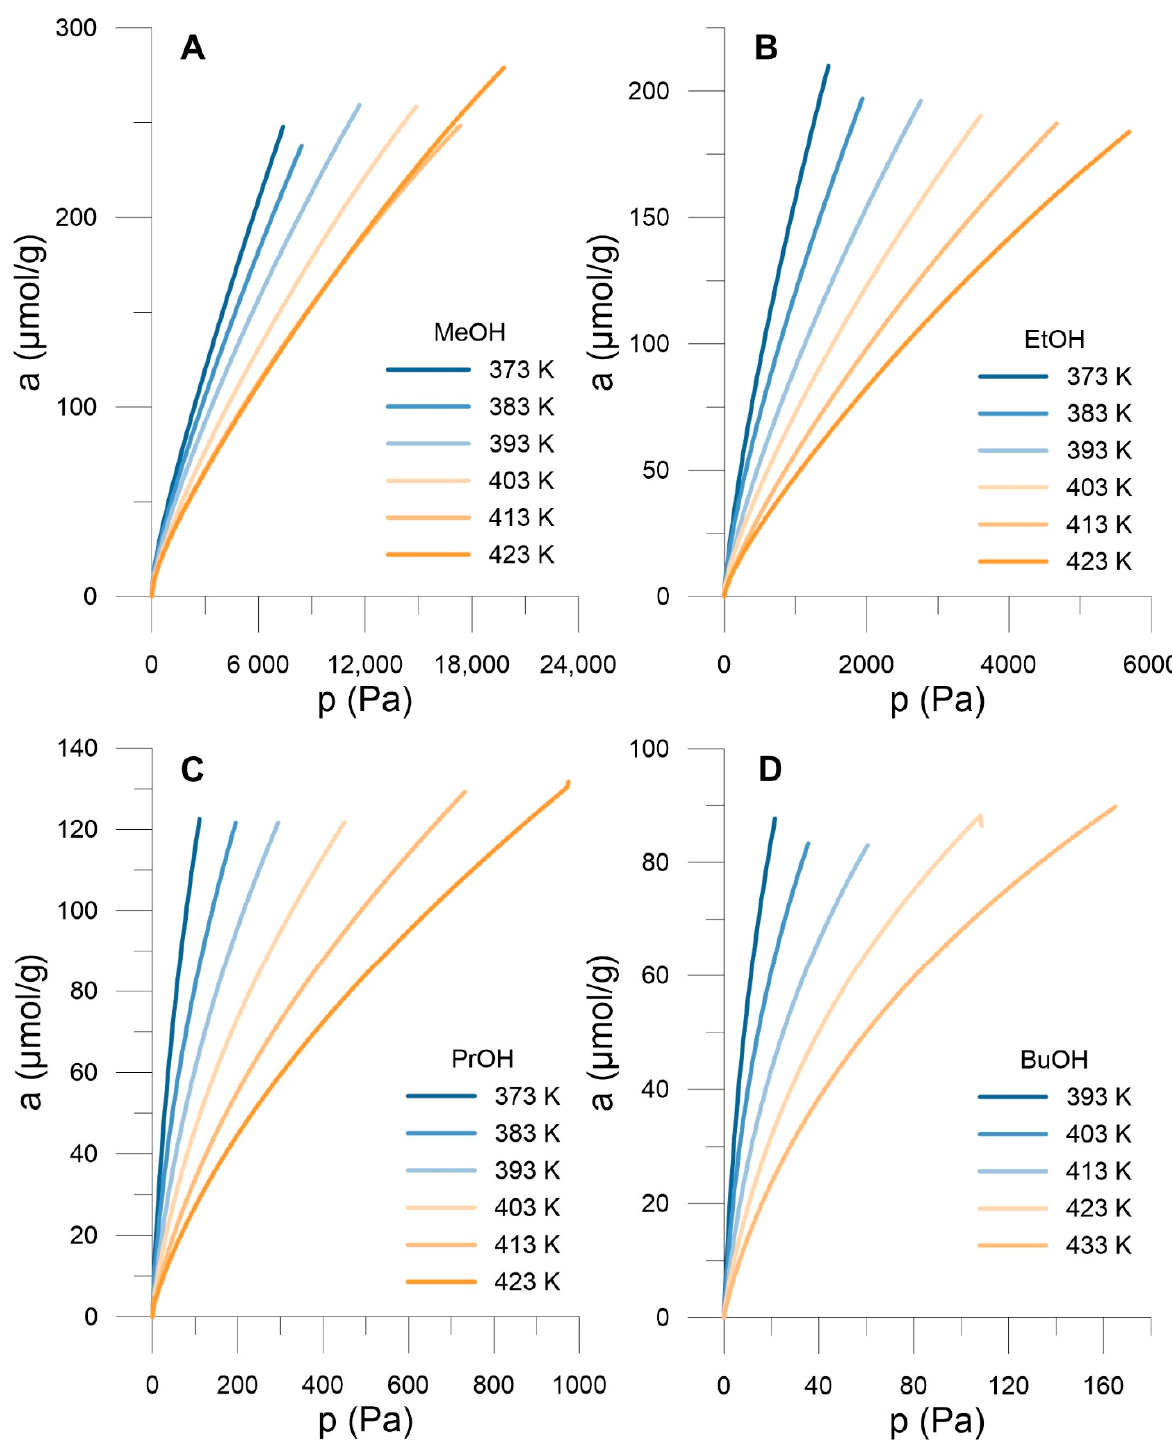
Figure 2. Adsorption isotherms of n-alcohols on SWCNH in the range of 373–433 K, MeOH ( A ), Et OH ( B ), PrOH ( C ) and BuOH ( D ).